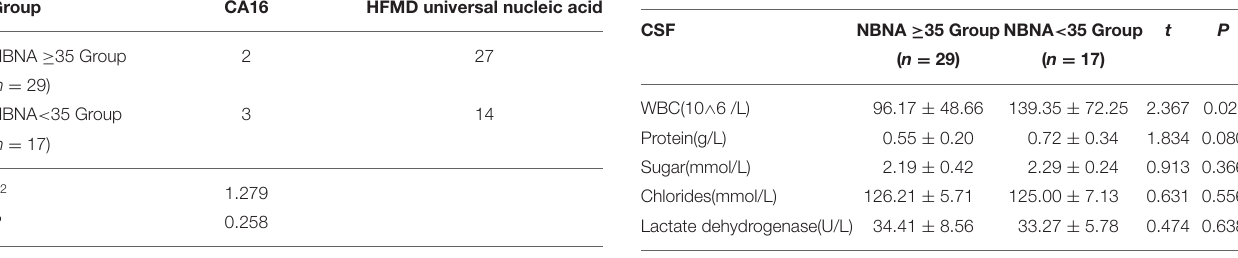
TABLE 3 | Routine comparison of CSF in newborns with HFMD complicated with encephalitis.